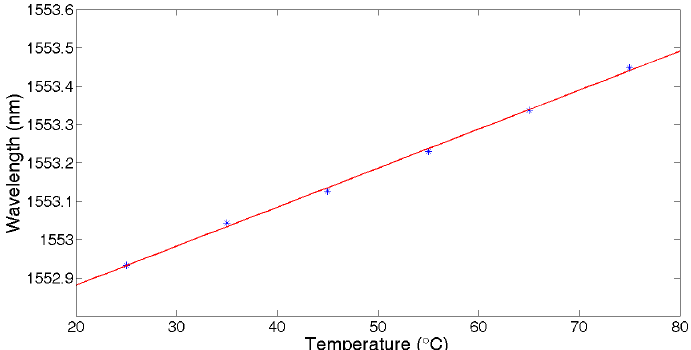
Figure 8. Central wavelength vs. temperature.